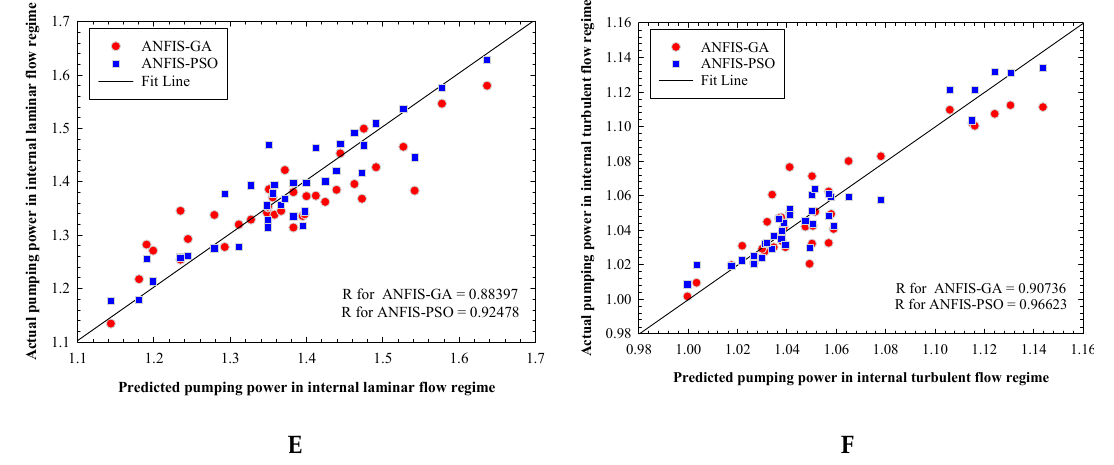
Figure 3. Regression plot for ( A ) thermal conductivity, ( B ) dynamic viscosity, ( C ) internal laminar flow, ( D ) internal turbulent flow, ( E ) internal laminar pumping power, and ( F ) internal turbulent pumping power prediction of Mg(OH) 2 -MWCNT-oil hybrid nanofluid.